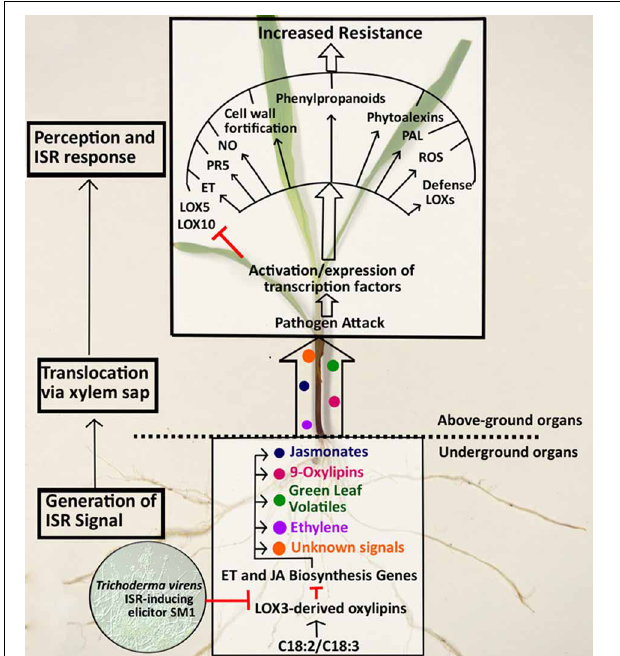
FIGURE 8 | Working model of ZmLOX 3 involvement in suppression of ISR Responses. In unperturbed maize roots, LOX3-derived oxylipins down-regulate defense-related genes and maintain levels of the defensive and developmental hormones, jasmonate (JA) and ethylene (ET) at healthy levels required for normal seed germination, plant growth, and normal life span (Gao et al., 2008). Upon colonization of roots, Trichoderma virens produces small molecules that possesses signaling activity and modulate gene expression in the roots to allow for mutualistic interactions with the host. One of such signal effecting expression of the host genes is a secreted proteinaceous elicitor, SM1 (Djonovic et al., 2007). One of the functions of SM1-mediated signaling is the down-regulation of expression of the host gene, ZmLOX3 , which, in turn, results in de-repression of several defense and signaling host molecules including 9/13-LOX products (such as JA, traumatin, green leaf volatiles, or other oxylipins derived either from C18:3 or C18:2 polyunsaturated fatty acids) and ET. Some of these metabolites, their derivatives or their precursors are transported via xylem into aboveground organs where they signal changes in transcription of a number of defense-related genes including, upregulation of pathogenesis-related genes (e.g., PR5), phenylalanine ammonia lyase (PAL), several defense related LOXs such as LOX1, LOX2, LOX9, and other genes required for biosynthesis of JA, ROS, NO, and cell-wall fortification (e.g., lignin), phytoalexins, and other defense-related metabolites. In addition to up-regulation of defense genes, the host susceptibility genes that promote colonization of tissues by diverse pathogens are down-regulated. This includes LOX10 and LOX5 genes shown to promote disease (Christensen, 2009; Park, 2011). Collectively, these reprogramming in metabolome